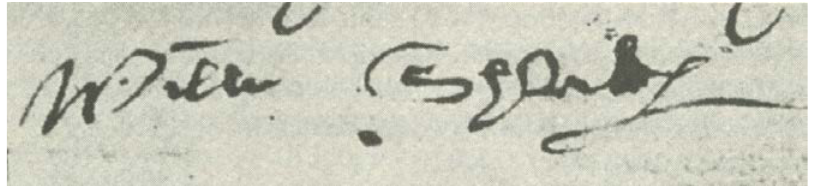
Fig. 1 – Signature n. 1 on the Mountjoy affidavit (1612)